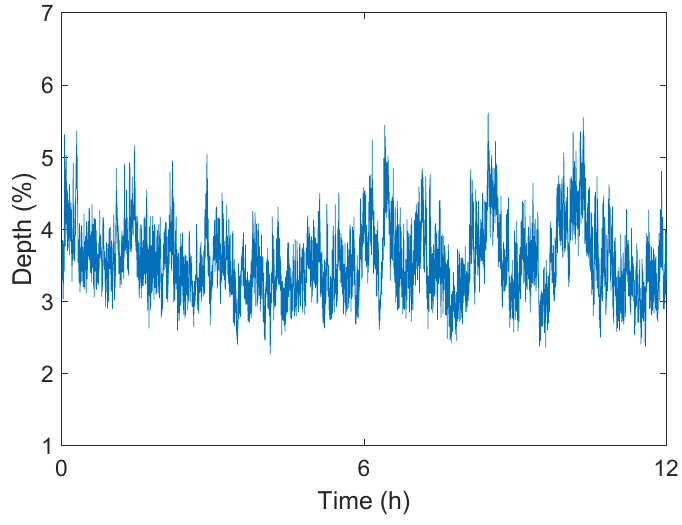
Figure 6. Depth test over 12 h.